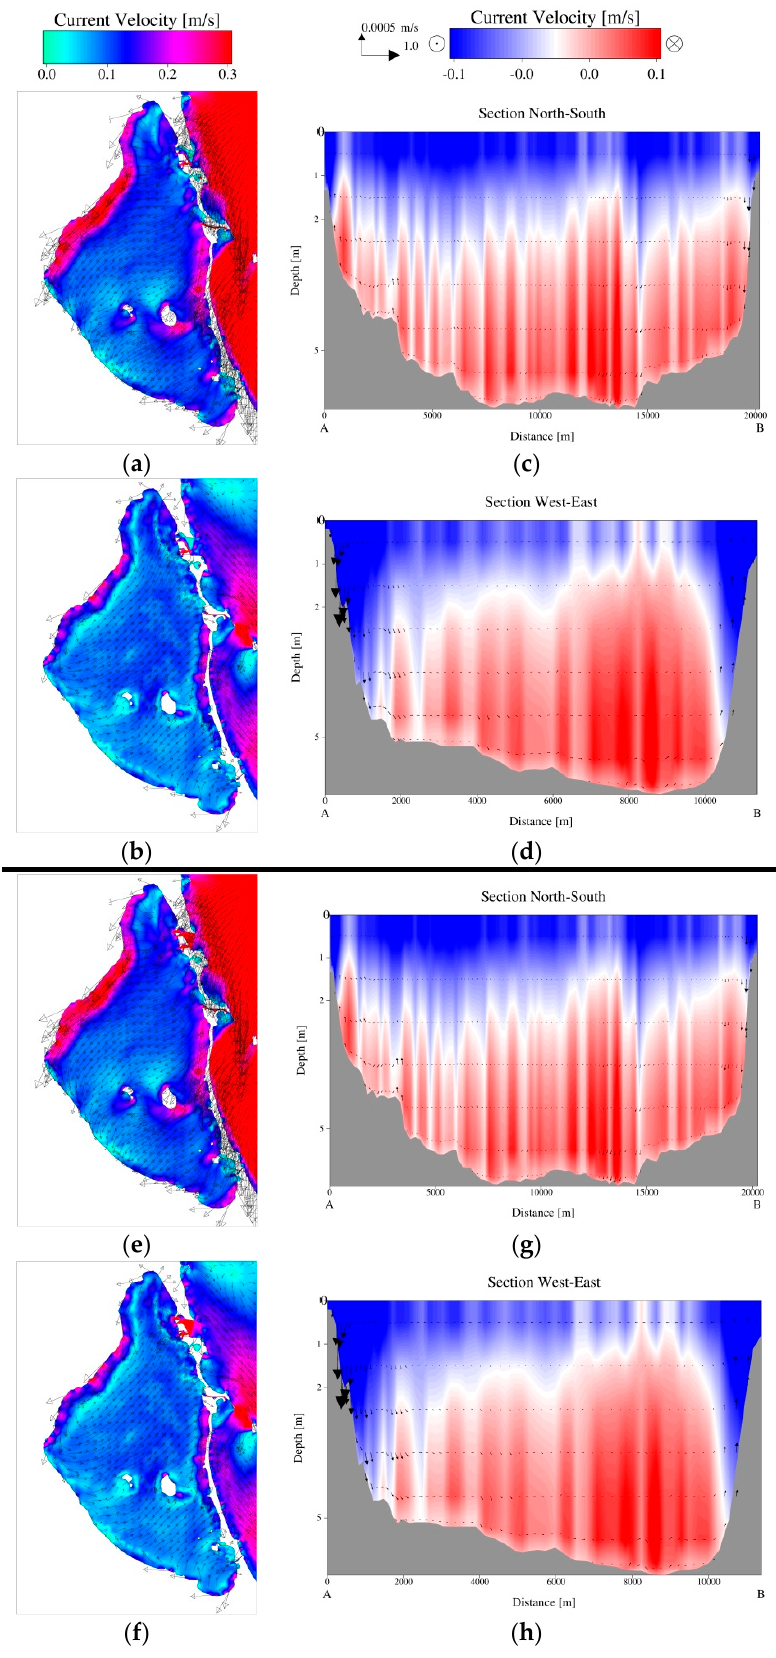
Figure 12. Current speeds for the Undisturbed ( top ) and the Enc_1m ( bottom ) scenario on 26 January 2010 at 10 h (maximum wind): velocities at the surface ( a , e ) and bottom ( b , f ) layers/transects at North ‐ South ( c , g ) and West ‐ East ( d , h ) sections. (Red: outwards/Blue: inwards directions).